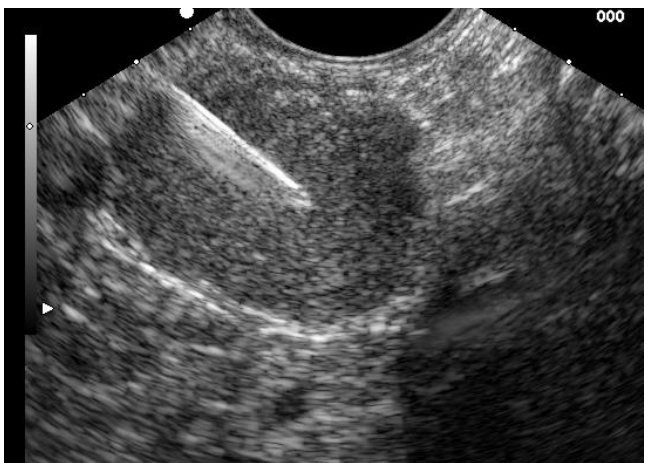
Figure 2. EUS-guided fine needle biopsy (FNB) of a suspicious lymphnode using a dedicated 22 G